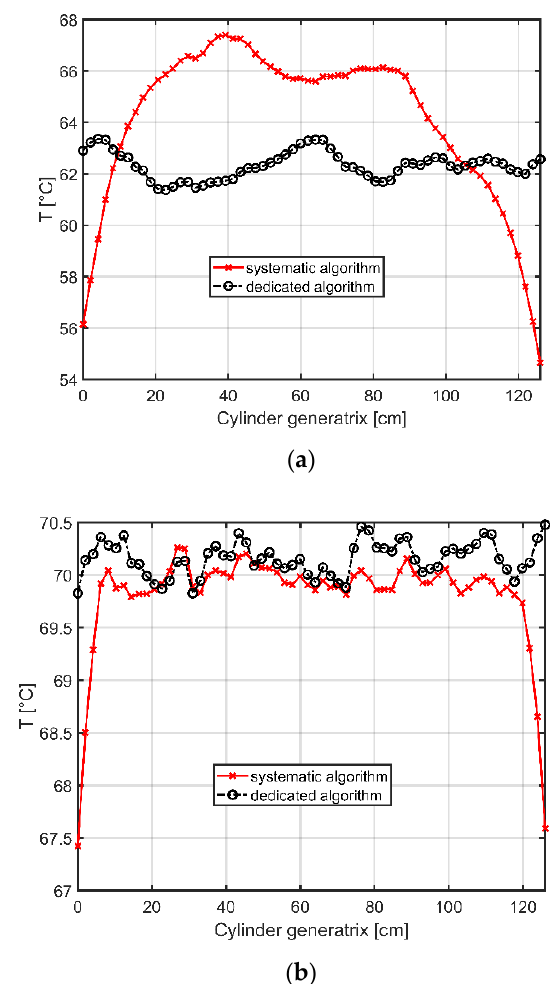
Figure 19. Temperature distribution along the forming cylinder obtained at time t 1 ( a ) and at the end of the experiment ( b ).